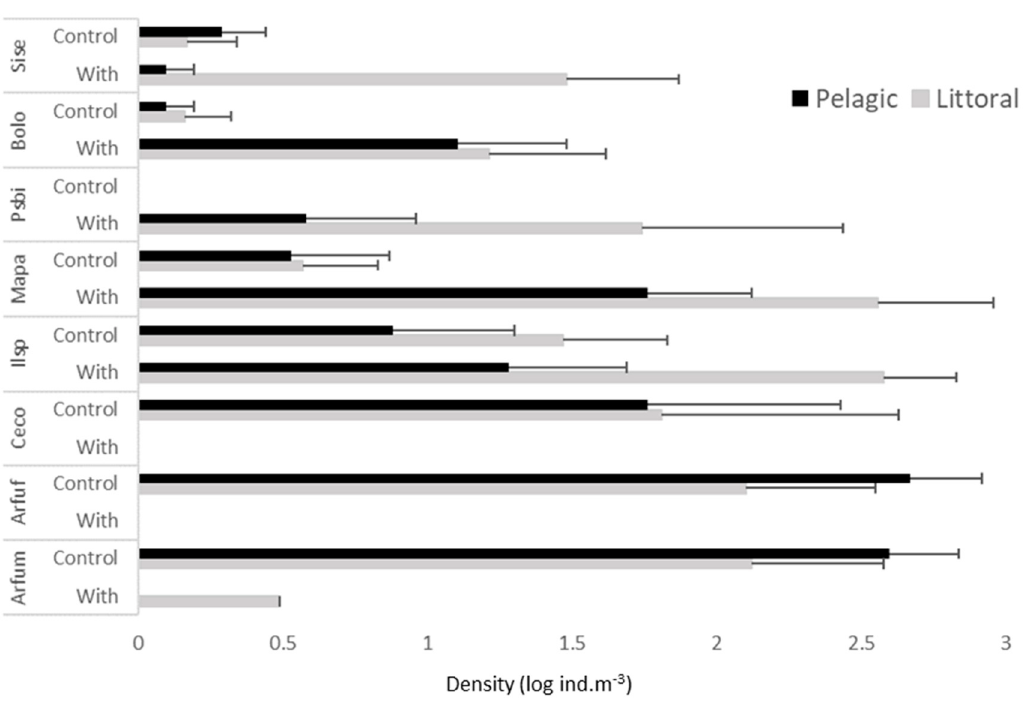
Figure 4. Mean logarithmic densities ( ± SE) by species in the littoral and pelagic habitats by macrophyte treatment.